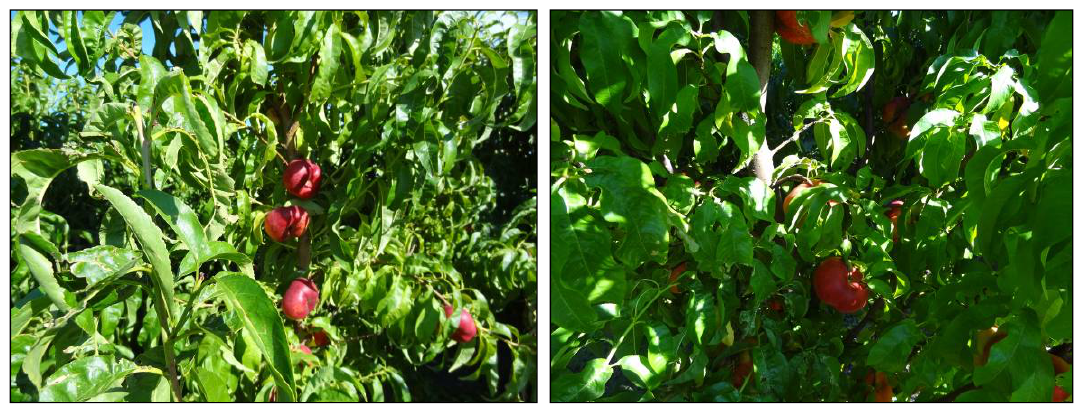
Figure 1. Different lighting conditions in the images from the orchard.